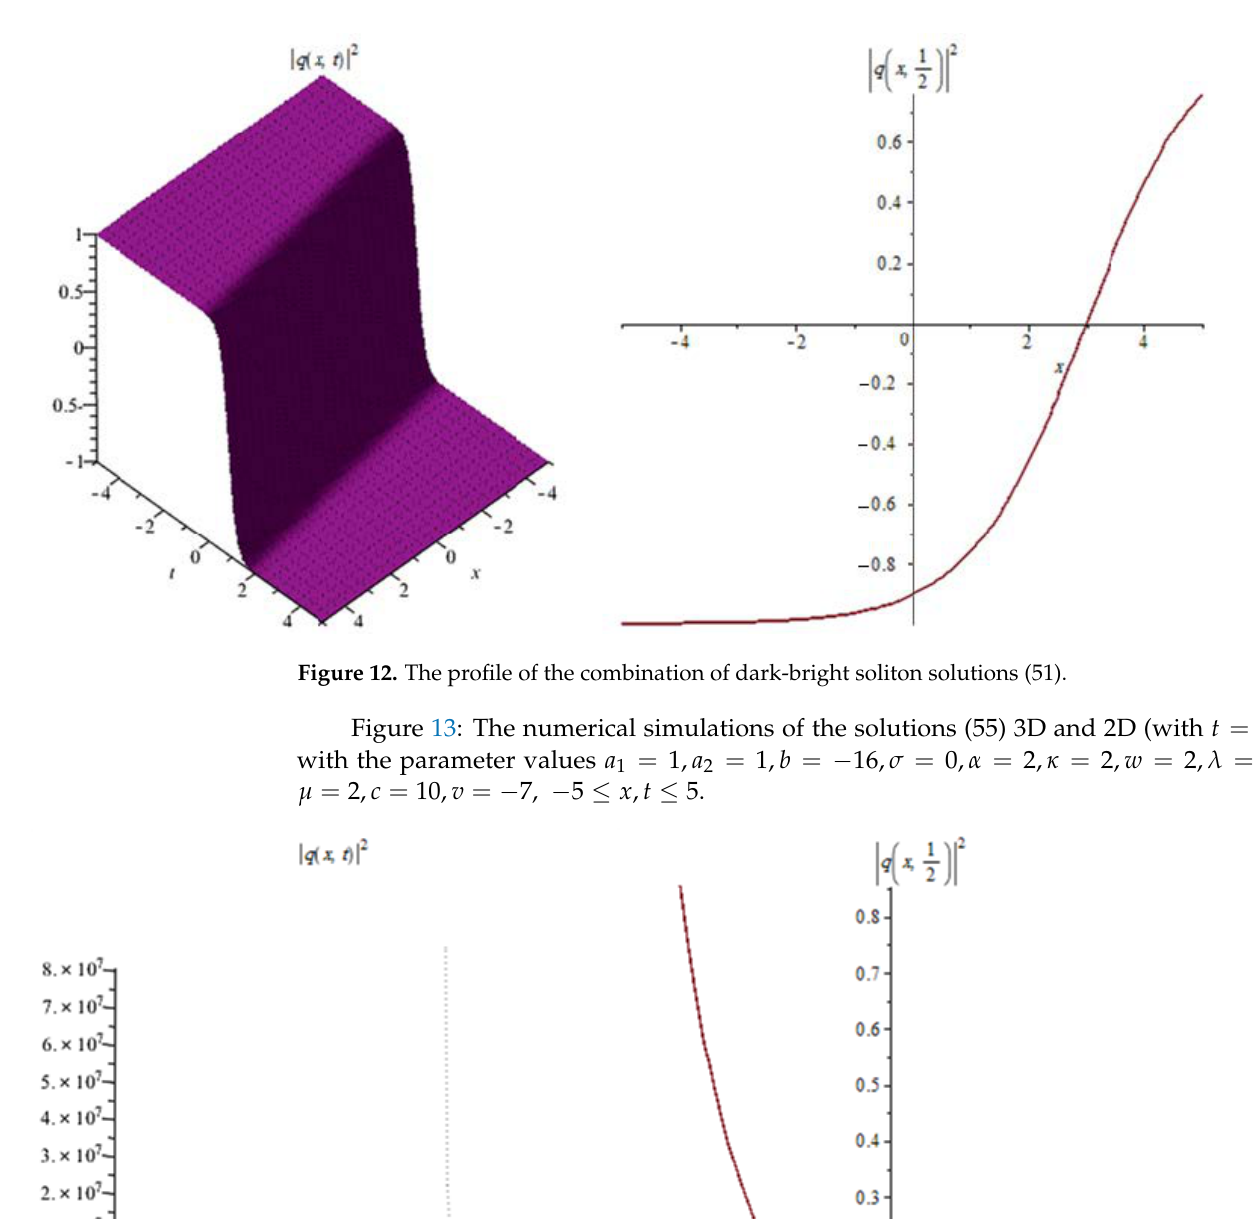
Figure 13. The profile of the combination of bright-dark soliton solutions (55). Figure 14: The numerical simulations of the solutions (55) 3D and 2D (with t = 1 with the parameter values a 1 = 1, a 2 = 1, b = 16, σ = 1, α = − 5 , κ = 2, w = 2, λ = 2, 3 − µ = 2, c = 10, v = 4 , 5 5. x , t 3 − ≤ ≤